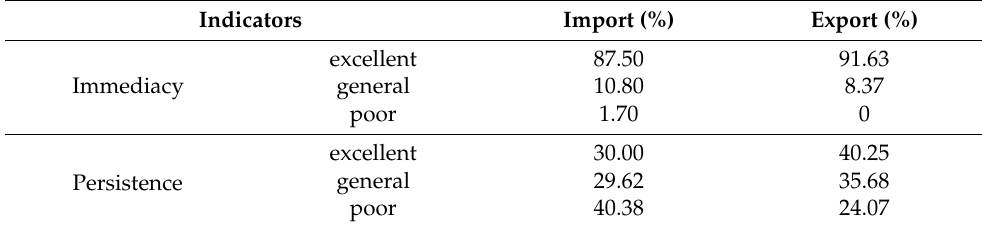
Table 2. Effectiveness test